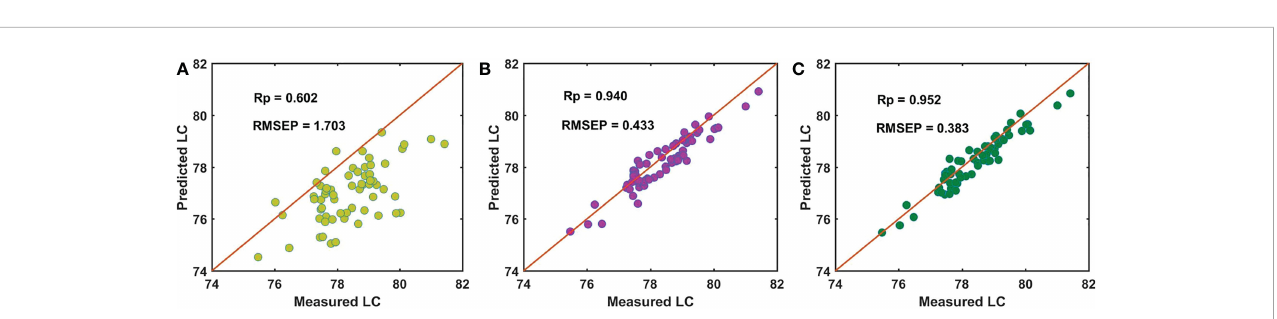
FIGURE 8 Performance for predicting LC of batch C of samples by (A) master model A, (B) Ind-model AC, and (C) Seq-model